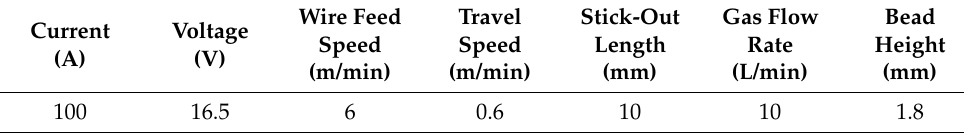
Table 1. Main parameters used in the deposition of AISI 316L stainless-steel by WAAM. Current